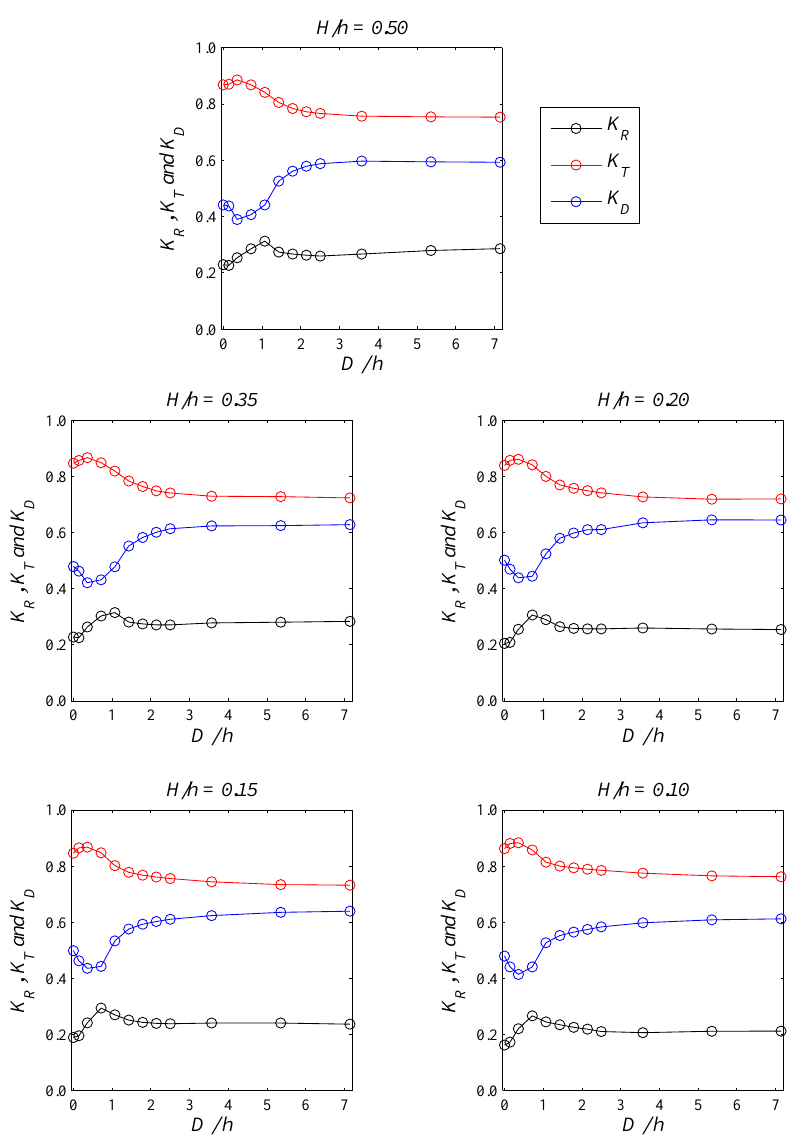
Figure 8. Effects of the horizontal distance ( D ) between two barriers on the energy reflection ( K R ), transmission ( K T ) and dissipation ( K D ) coefficients, for the cases of H / h = 0.50, 0.35, 0.20, 0.15 and 0.10.